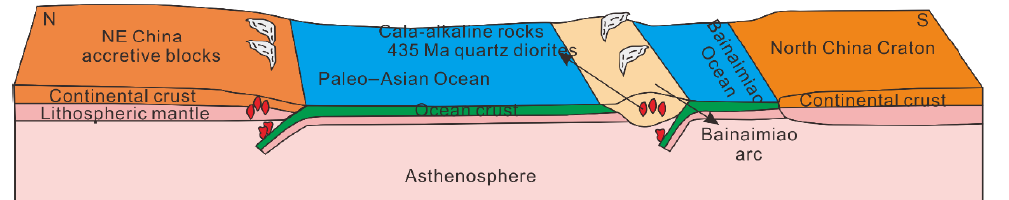
Figure 14. Schematic diagram of the eastern PAO from Paleozoic to Early Triassic in the southeastern CAOB. ( a ) northward subduction of the Bainaimiao ocean; ( b ) closure of the Bainaimiao ocean; ( c ) post-collision extension of the Bainaimiao ocean; ( d ) double-sided subduction of the Paleo-Asian Ocean; ( e ) final closure of the Paleo-Asian Ocean; ( f ) post-collision extension of the Paleo-Asian Ocean.